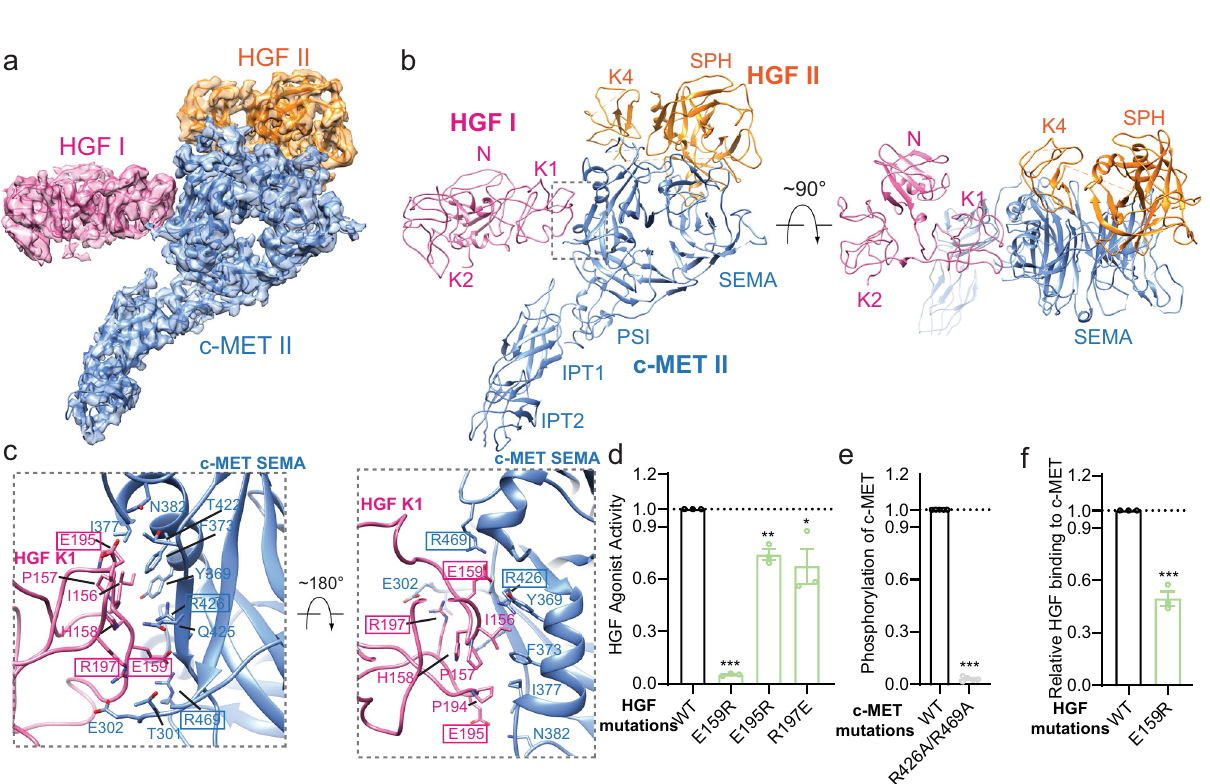
Fig. 2 Four interfaces between c-MET I and HGF I. a 3D reconstruction of the 1:1 c-MET I/HGF I complex after focused 3D re fi nement of holo-complex, and the corresponding ribbon representation of this complex fi tted into the cryo-EM map at 4.5 Å resolution. b The ribbon representation of the c-MET I/ HGF I complex shown in side and top views. Four distinct interfaces that are involved in the interaction between c-MET I and HGF I are indicated by dash boxes. Heparin is shown in yellow as a stick model. c – e Close-up views of interfaces I, II, and III. The HGF and c-MET residues mutated for cell-based activity assays are indicated by rectangular boxes. f The levels of c-MET autophosphorylation in response to HGF wild-type (WT) or indicated mutants that were expected to disrupt c-MET I/HGF I interaction. Mean ± SEM are from N = 3 independent biological repeats. The representative raw western blot data were shown in Supplementary Fig. 5. g HGF-induced c-MET autophosphorylation in H1299 cells expressing c-MET WT or indicated mutants that were expected to disrupt C-MET I/HGF I interaction. Mean ± SEM are from N = 5 independent biological repeats. The representative western blot data were shown in Supplementary Fig. 6. h SDS-PAGE of TSE pull-down binding assay. TSI tagged c-MET927 was immobilized to TSE resin as bait and incubated with HGF WT and various of mutations as prays. i Quanti fi cation of the pull-down binding results for the HGF R242E/K244E/R249E, W321R/E361R/ Y376A, and Y673A mutants shown in h . Mean ± SEM are from N = 3 independent biological repeats. Statistical difference in f , g , and i was analyzed using two-tailed Student ’ s t -test, and P values were calculated between WT and mutants: ns, P > 0.05; * P ≤ 0.05; ** P ≤ 0.01; *** P ≤ 0.001. Source data are provided as a Source Data fi le. Exact P values in f from left to right: <0.0001, 0.0124, 0.0083, <0.0001, 0.0021, 0.0251, 0.0184, 0.0361, 0.0020, 0.0284, 0.9957, 0.9414, 0.4498, 0.0038, 0.0013, <0.0001, <0.0001. Exact P values in g from left to right: <0.0001, 0.0042. Exact P values in i from left to right: 0.0353, 0.0424, 0.0006.